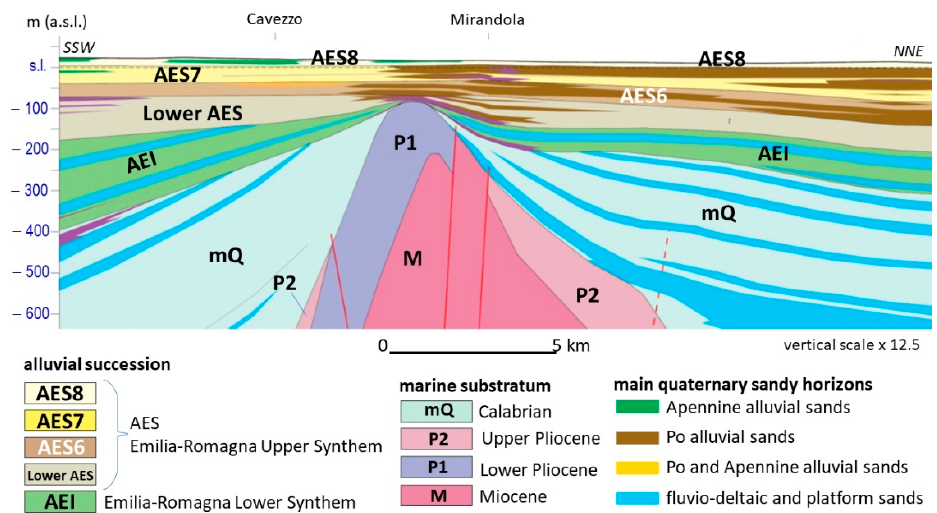
Figure 5. Geological cross-section through the Modena plain and the Mantua Province south of the Po River [19]; trace in Figure 4.